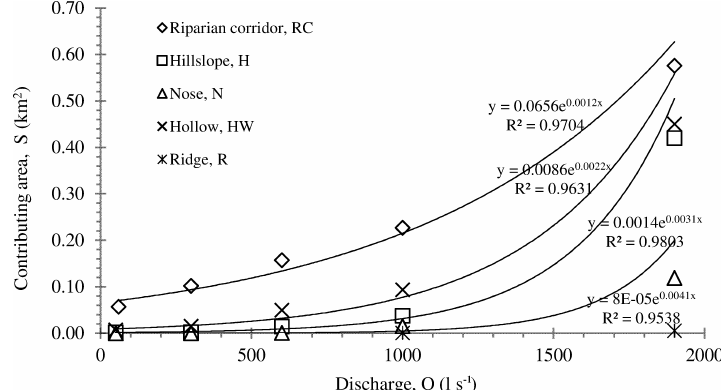
Figure 14. Plot of the contributing area vs. discharge from data in Table 3.